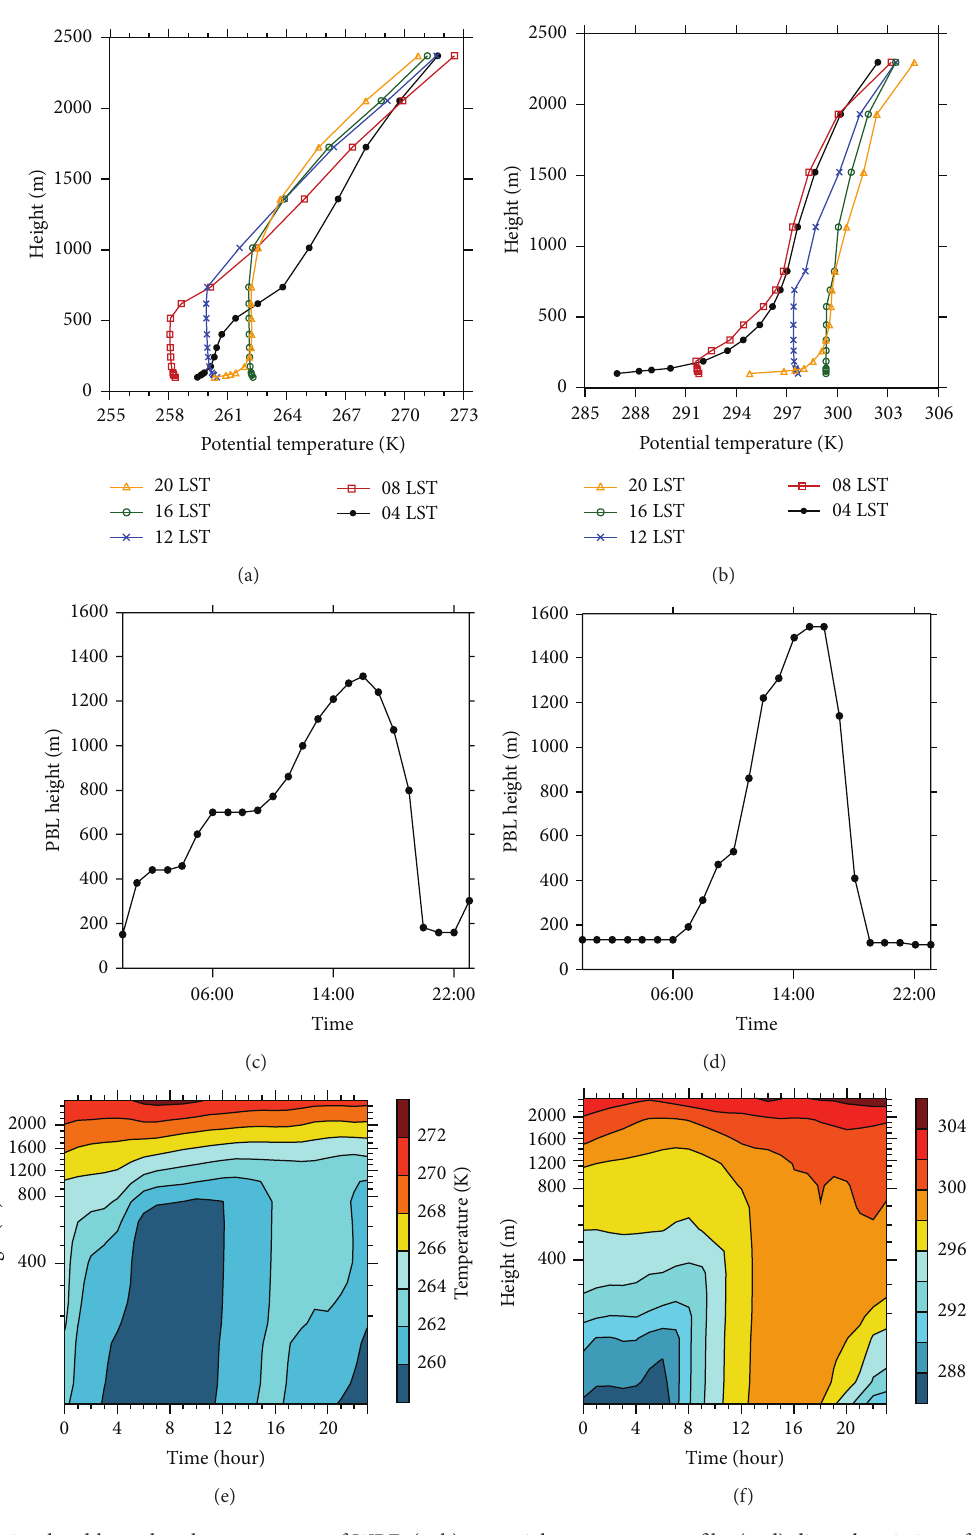
Figure 6: The simulated boundary layer structure of WRF: (a, b) potential temperature profile; (c, d) diurnal variation of boundary layer height; (e, f) height-time section of potential temperature; (a, c, e) simulation on 16 February 2012; (b, d, f) simulation on 13 August